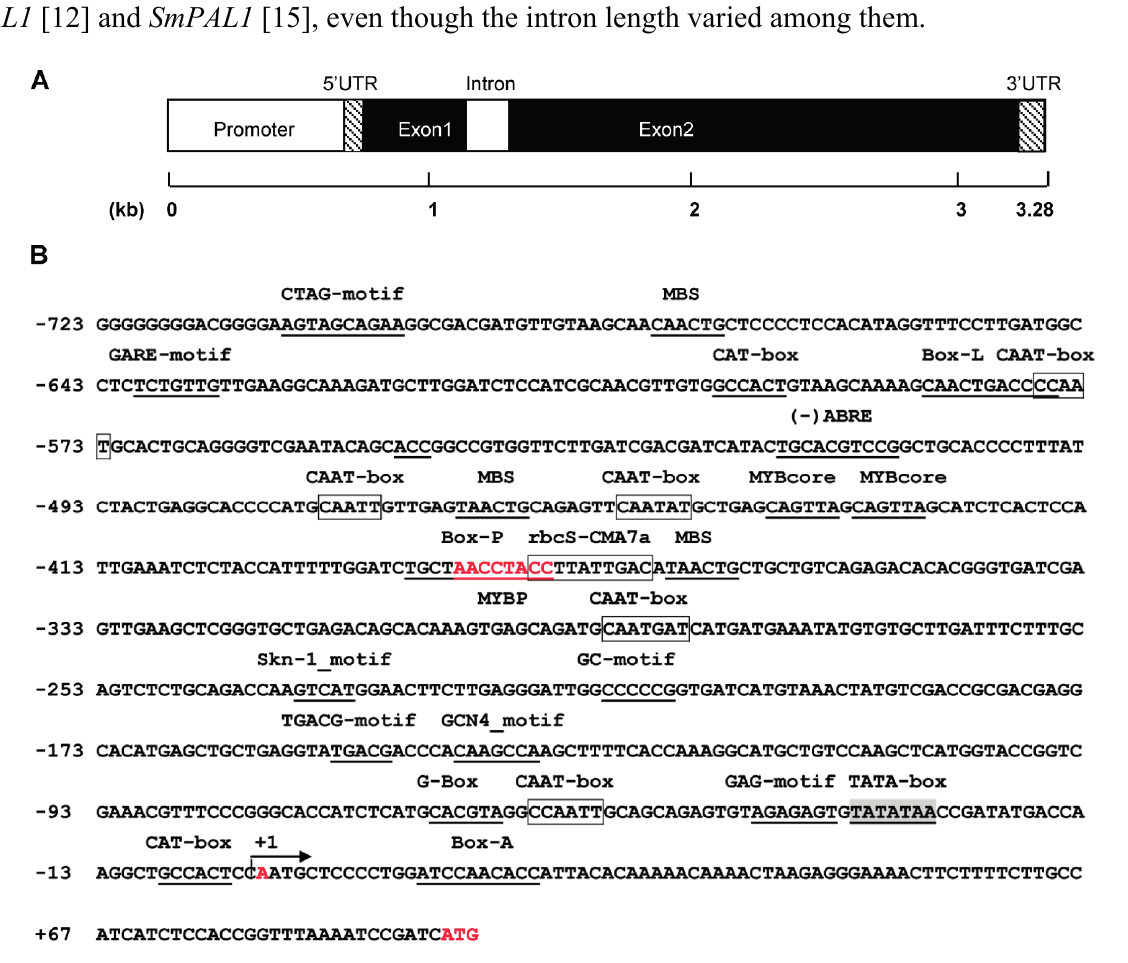
Figure 5. The genomic organization and the predicted cis -acting elements in the 5 ′ upstream region of SsPAL1 . ( A ) The promoter, 5 ′ -UTR, 3 ′ -UTR, exons and intron are shown in the figure; ( B ) the translation start site (ATG), transcription start site (+A) and conserved MYBP motif (AACCTACC) are shown in red, respectively. The most probable TATA box is shaded and underlined. The CAAT motifs and rbcS-CMA7a are boxed and other predicted cis -acting elements